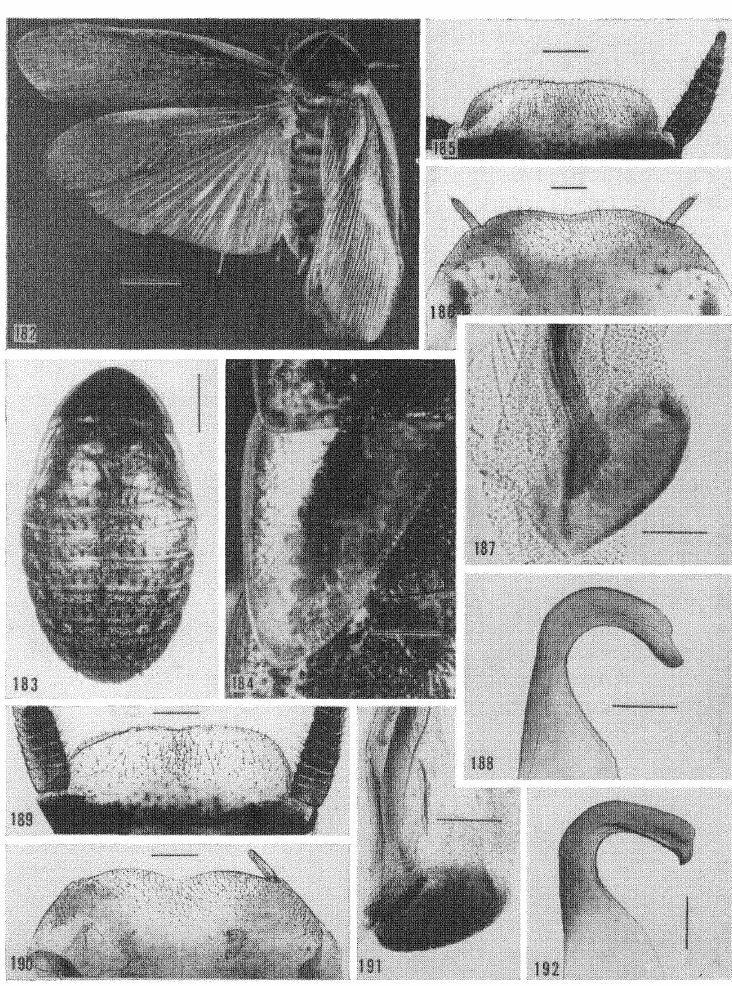
Figures 182-192. CalolamIra fraserensis. 182. (5 SAM), lectotype, Fraser Range, W. A. 183. (138 MCZ), Rottnest Island, W. A. 184. Tegmen of shown in figure 183. 185-188. Supra-anal plate, hypandrium, and genitalia of leetotype shown in figure 182. 189-192. (SAM), Mt. Bryan East, S. A. 189-190. Supra-anal plate and hypandrium. 191-192. Genitalia. Scale: Figs. 182, 183 mm; Figs. 184 ram; Figs. 185-186, 189-190 0.5 ram; Figs. 187-188, 191-192 0.2